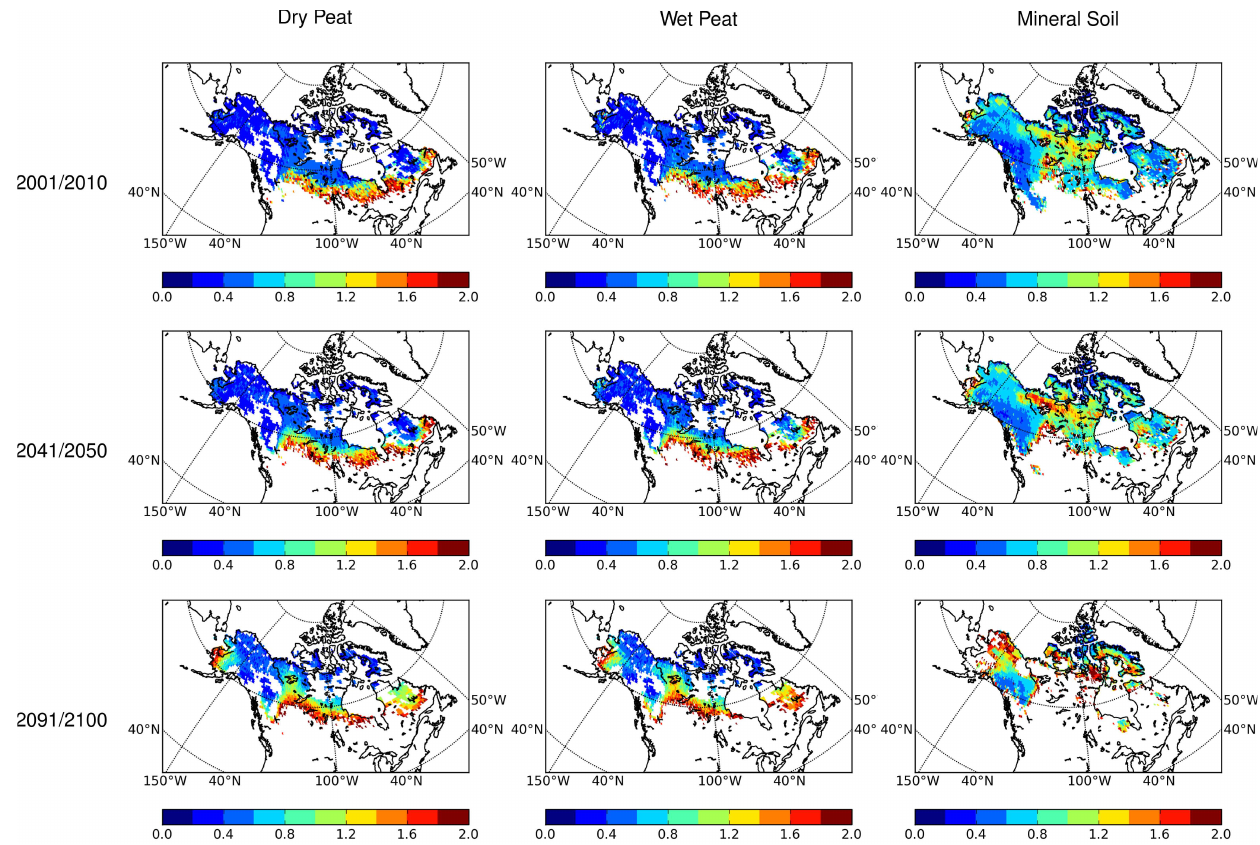
Fig. 5. Modeled average ALT [m] under contemporary (2001/2010), mid-century (2041/2050) and end-century (2091/2100) climate condi- tions for dry peat (left), wet peat (middle) and mineral soils (right). ALT > 2.0m is masked